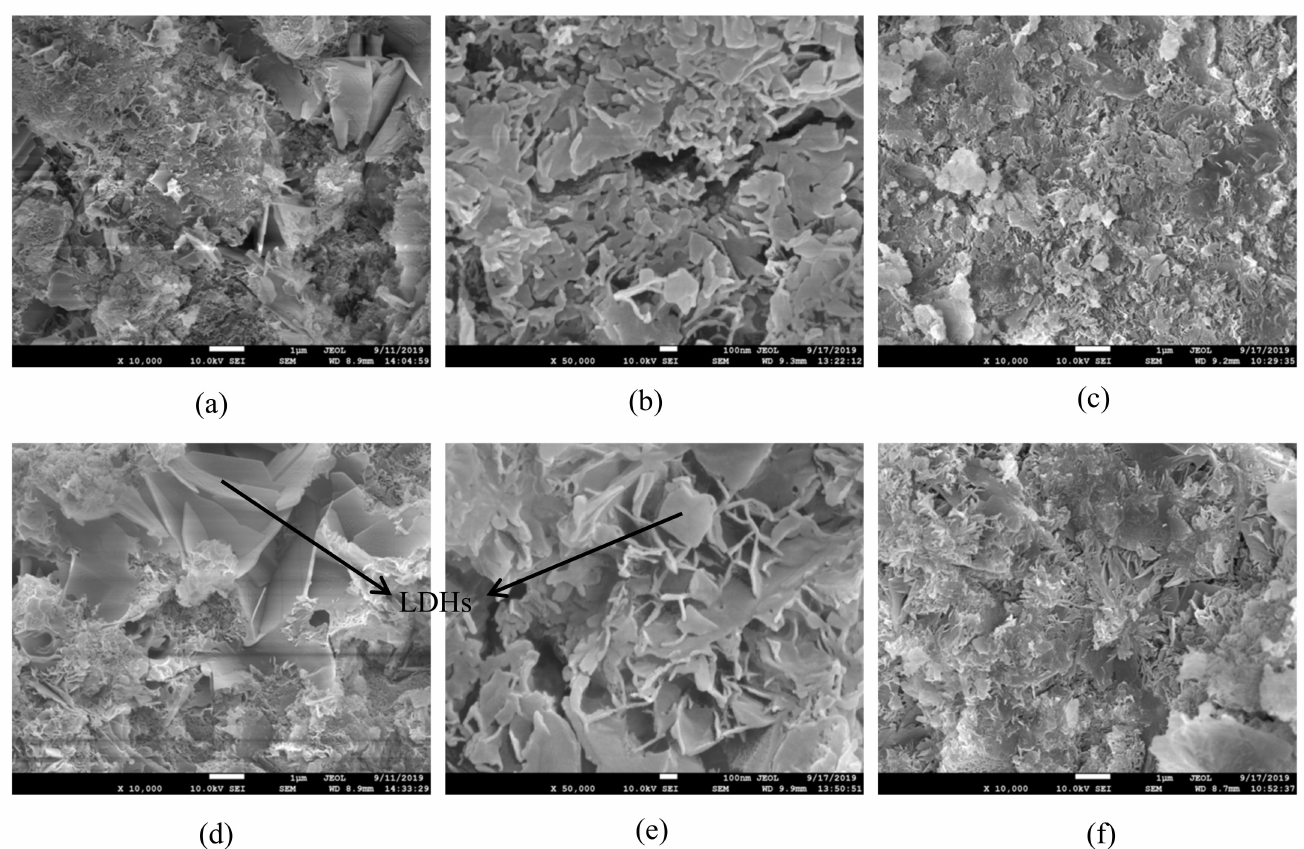
Figure 8. SEM pictures of specimens cured for different days. ( a ) Control 1 day; ( b ) Control 3 day; ( c ) Control 28 day; ( d ) NM0.09 1 day; ( e ) NM0.09 3 day; ( f ) NM0.09 28